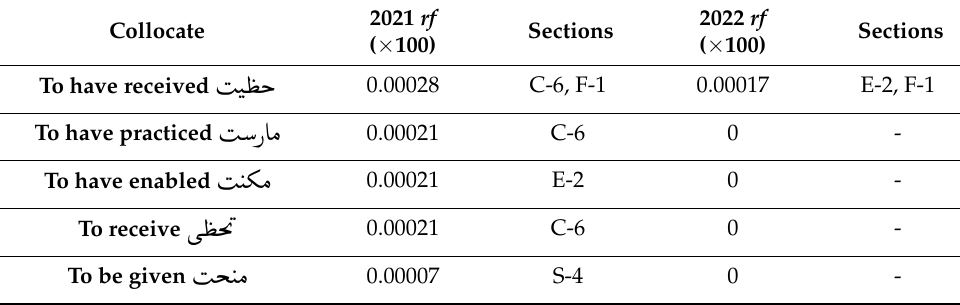
Table 11. Verbal co-occurrences rf = (>0.00001 × 100) for 2021 and 2022. Collocate